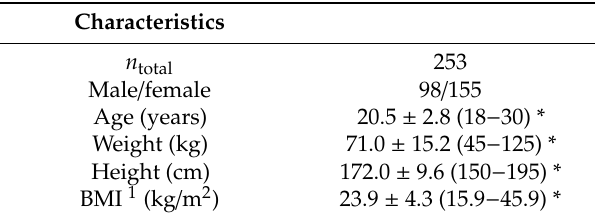
Table 1. Participant